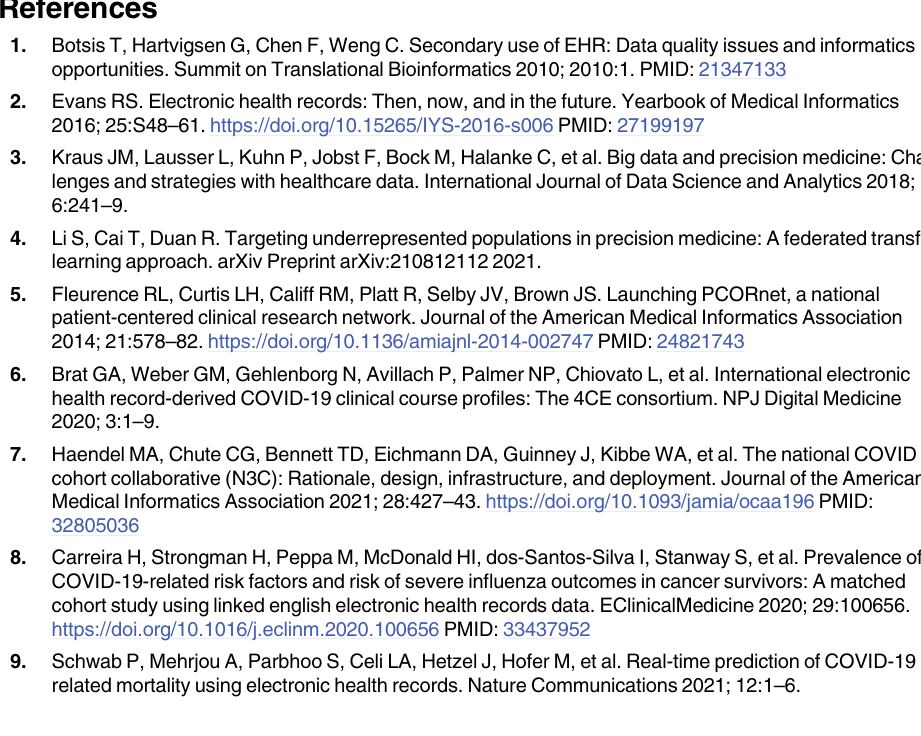
S4 Table. Local variance parameter estimates at each facility. We demonstrated variance- component parameter estimates obtained separately for each site to evaluate our assumption of equal variance-component parameters across sites. For sites with a relatively small number of records, the estimates were obtained by fitting the GLMM locally. For sites with a large number of records, the estimates were obtained by a meta-analysis aggregating the GLMM estimates from split data batches. The variance- component parameter estimates for both patient- and physician-level random effects are similar across the sites, supporting our model specification with homogenous variance-component